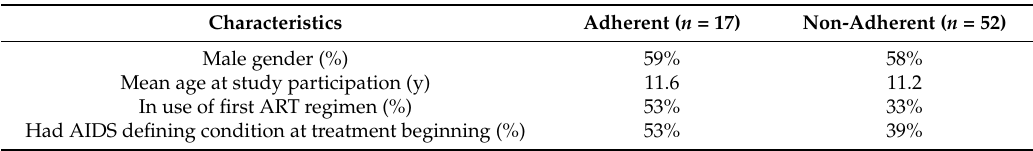
Table 1. Clinical characteristics of adherent and non-adherent CALHIV receiving antiretroviral treatment in five centers in different geographic regions of